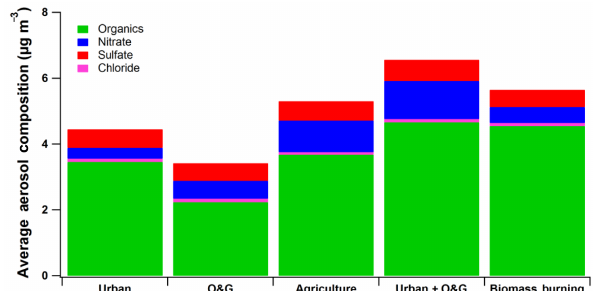
Figure 3. Average chemical composition (µgm − 3 ) of non- refractory aerosols for different air mass